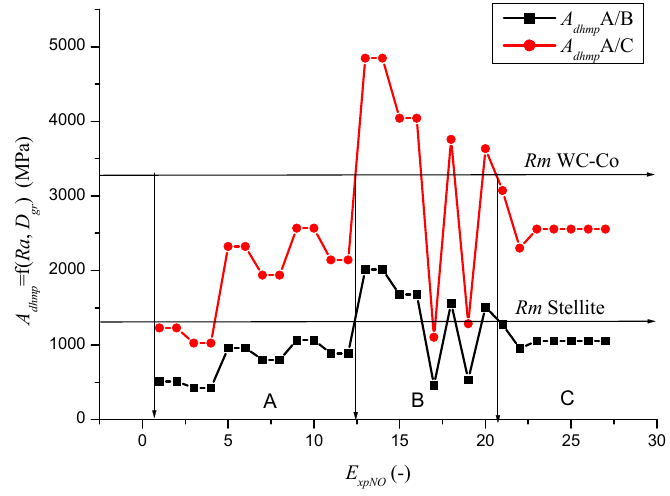
Figure 8. Adhesion A dhmp = f ( Ra , D gr ) for the combination A / B and A / C, where: Section A ( E xpNO 1–12) insu ffi cient roughness for the desired adhesion, Section B ( E xpNO 6–21) very good roughness for the desired adhesion, Section C ( E xpNO 21–28) su ffi cient roughness for the desired adhesion.